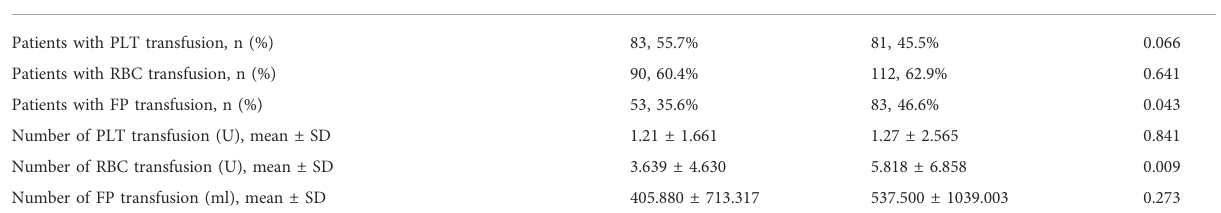
TABLE 3 Laboratory tests of all enrolled